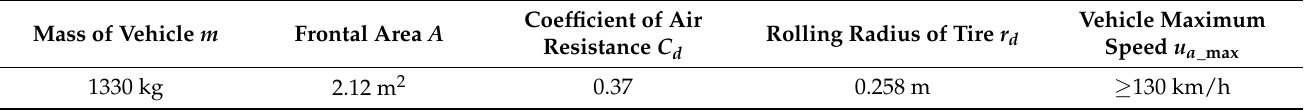
Table 1. The vehicle parameters of